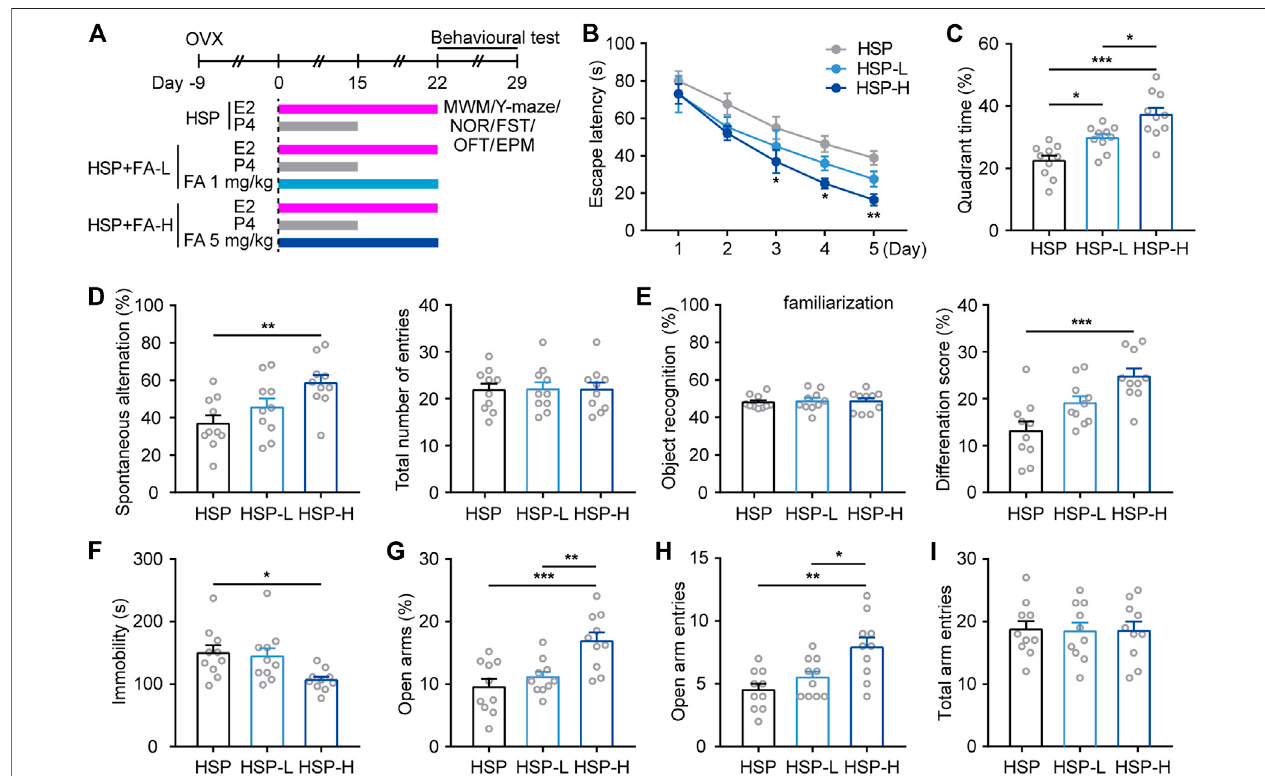
FIGURE 2 | Effects of FA on cognitive- and emotional-related behaviors in female HSP mice. (A) Schematic representation of the experimental procedure for assessing the effects of FA administration in HSP mice. (B) Escape latency to the hidden platform in the training phase test of the MWM. Two-way repeated measures ANOVAwasused toanalyze the latency during the navigation training: F (4, 36) (cid:2) 45.19, p < 0.0001. * p < 0.05; ** p < 0.01; *** p < 0.001 HSP-H compared with HSP. (C) The percentage oftimespentexploring thetarget quadrant. One-wayANOVA: F(2, 27) (cid:2) 16.31, p < 0.0001. (D) Thespontaneousalteration rateandtotal number of entries were analyzed in the Y-maze task. One-way ANOVA: F (2, 27) (cid:2) 5.796, p (cid:2) 0.0081. One-way ANOVA: F (2, 27) (cid:2) 0.004526, p (cid:2) 0.9955. (E) FA signi fi cantly improved the ability to discriminate a novel object with a familiar object in HSP mice while had little effect on the preference for objects during familiarization. One-way ANOVA: F (2, 27) (cid:2) 0.06243, p (cid:2) 0.9396. One-way ANOVA: F (2, 27) (cid:2) 10.89, p (cid:2) 0.0003. (F) FA-treated mice also exert less immobility in the FST. One-way ANOVA: F (2, 27) (cid:2) 4.464, p (cid:2) 0.0211. (G) FA administration increased open arm exploring time in HSP mice. One-way ANOVA: F (2, 27) (cid:2) 9.777, p (cid:2) 0.0006. FA administration increased open arm entries number in HSP mice (H) , with little changes on total arm entries (I) . One-way ANOVA: F (2, 27) (cid:2) F (2, 27) (cid:2) 15.25, p < 0.0001. One-way ANOVA: F (2, 27) (cid:2) 0.1126, p (cid:2) 0.8939. Data were presented as scatter points plus mean ± SEM. n (cid:2) 10 for each group. * p < 0.05; ** p < 0.01; *** p < 0.001.